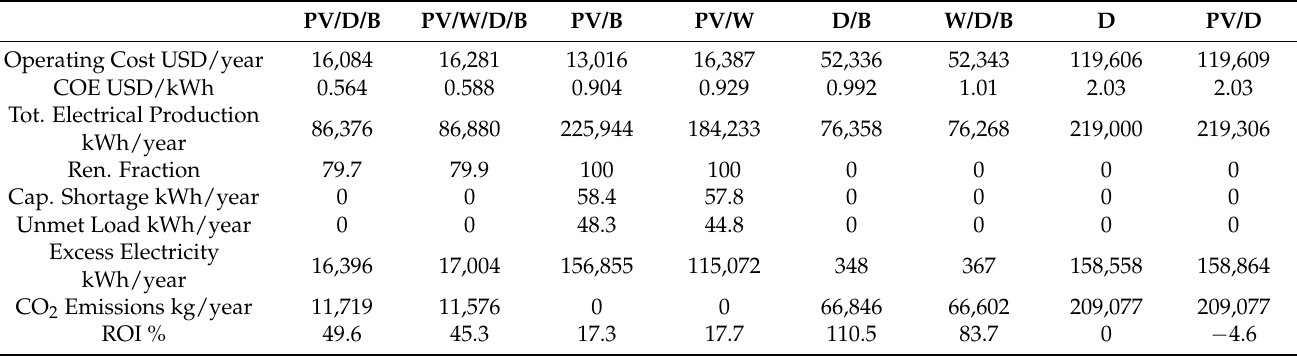
Table 3. HOMER output for scenario 2 with diesel generator and renewable